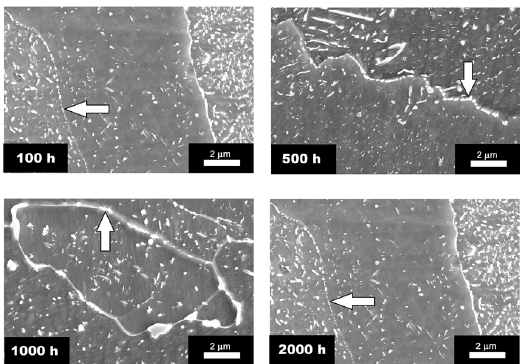
Figure 5: Ferritic-bainitic steel scanning electron micrographs at 600°C and 100, 500, 1000 and 2000 h of aging. The arrows indicate the carbides coarsening effect.